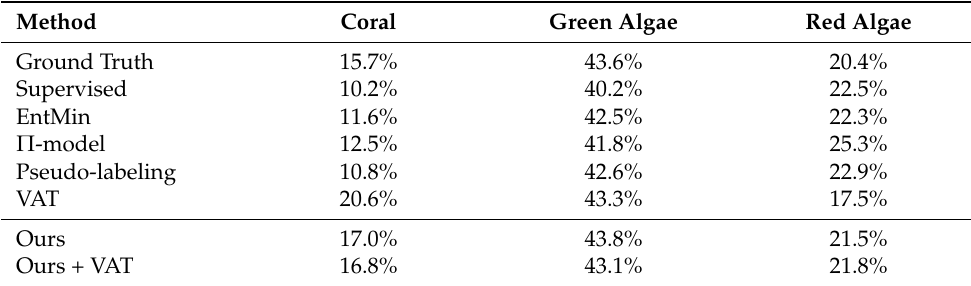
Figure 7. Coral image segmentation on test dataset with different methods. Blue color represents coral, green color represents green algae, red color represents red algae, gray color represents rock and yellow color represents other species. Table 2. Coral, green algae and red algae abundance detected with different method on test